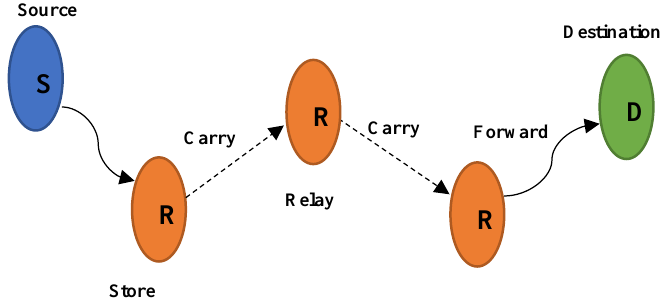
Figure 1. The Store-Carry-Forward message switching paradigm in DTN.